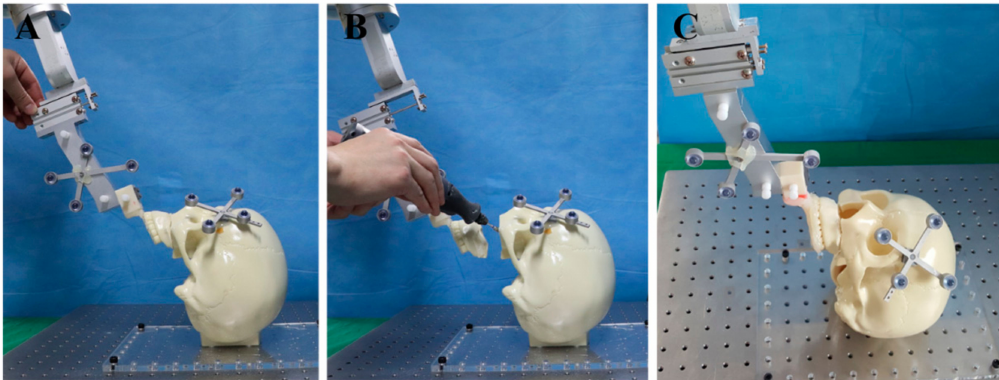
Figure 5. Identification ( A ) and removal ( B ) of the bony interference. ( C ) Final position of the maxilla according to the surgical